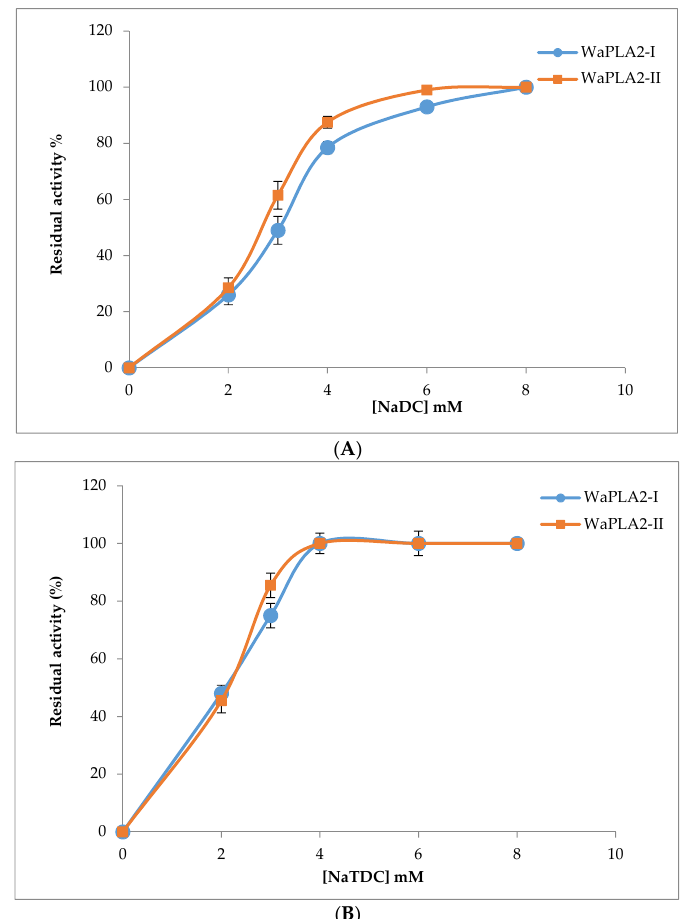
Figure 6. The effect of increasing concentrations of NaDC ( A ) and NaTDC ( B ) on Wa PLA 2 -II and -I activities. sPLA2 activity was measured using PC as a substrate at pH 9.5 and 55 °C for WaPLA 2 -II, and at 45 °C and pH 8.5 for Wa PLA 2 -IA, in the presence of 10 mM Ca 2+ . The results represent the means of three independent experiments and expressed as the mean ± SD (n = 3).